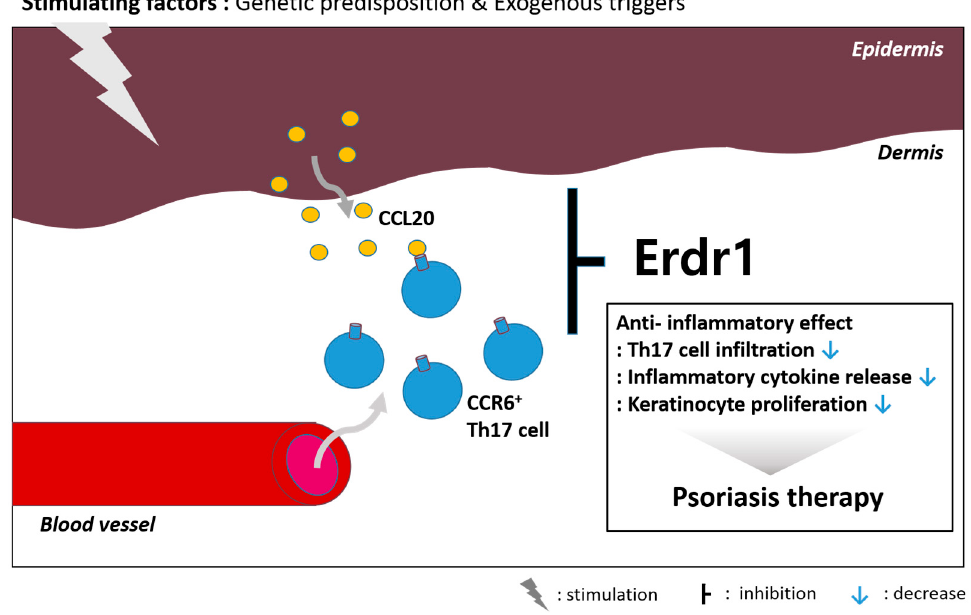
Figure 2. Erdr1 is a potential therapeutic molecule for psoriasis due to its role in suppressing inflammation. Genetic and environmental triggers stimulate the epidermis, which produces chemokines for inflammatory immune cell infiltration. More specifically, Erdr1 inhibits the infiltration of CCR6 + Th17 cells via blockade of CCL20.